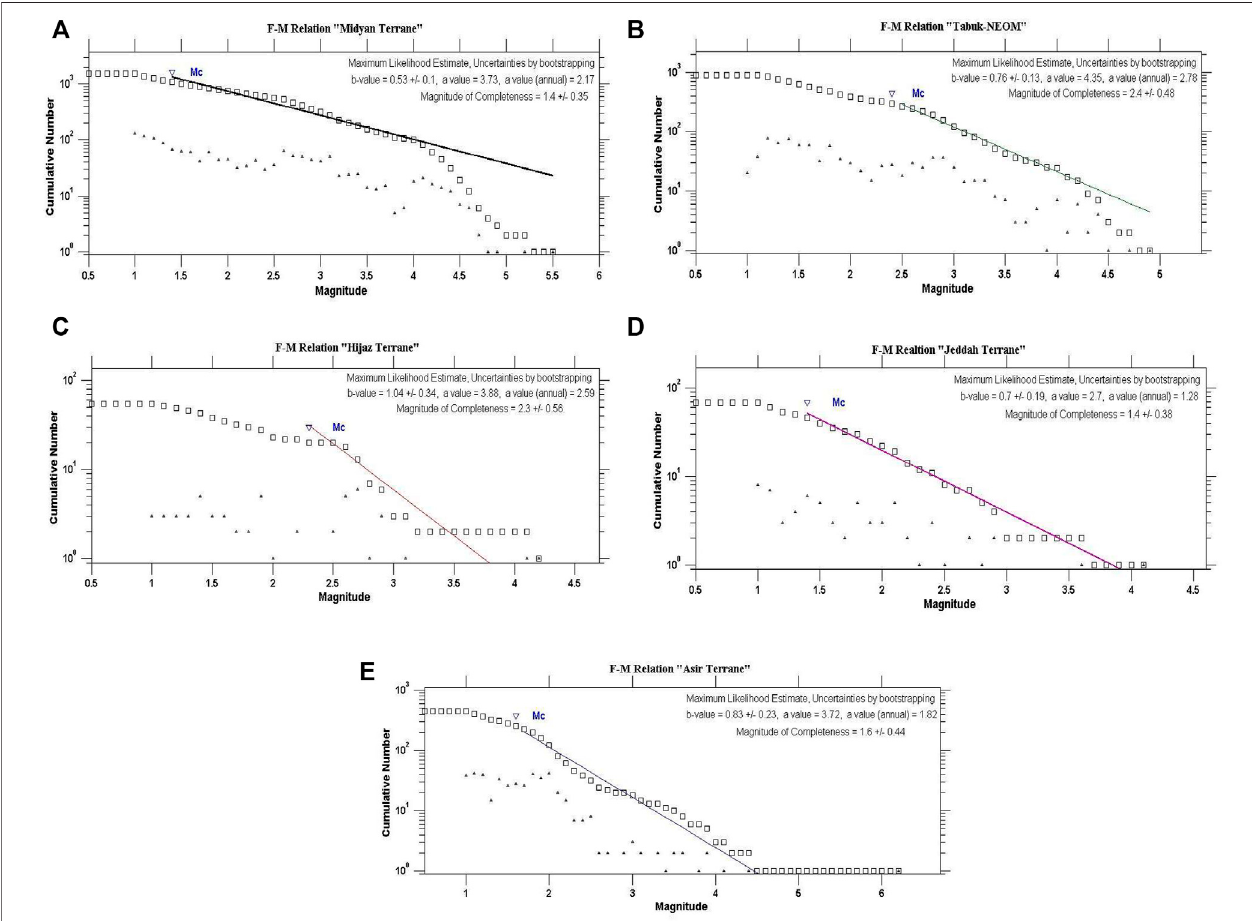
FIGURE 8 | (A – E) Frequency – magnitude relations of the studied seismic regions calculated by the maximum curvature technique. Mc is the cut-off magnitude (squares and triangles show the cumulative earthquakes for each magnitude value, as well as the earthquake numbers, respectively).